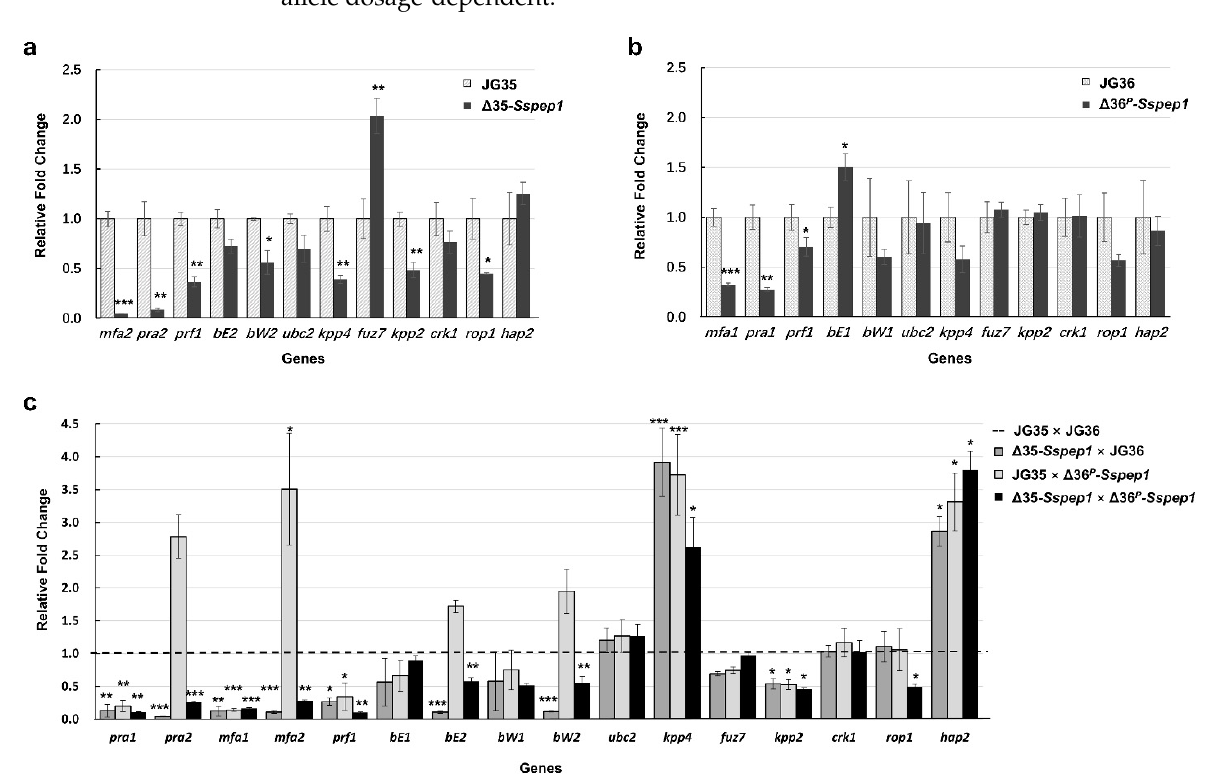
Figure 3. Effects of Sspep1 deletion on the expression of genes essential for mating and filamentous growth in haploid and dikaryon stages. RT-qPCR was used to quantify the accumulation of target genes. ( a ) ∆ 35- Sspep1 ; (b) ∆ 36 P -Sspep1 ; ( c ) mating pairs. The levels of gene expression in the wild-type haploid strains ( a , b ) or pairs of wild-type strains ( c ) were set as 1.0. The actin gene of S. scitamineum was used as an endogenous control. Means ± S.E. were derived from three independent biological repeats, each of which contained three technical repeats. p -values were calculated based on a Student’s t -test of replicate 2 − ∆∆ Ct values for each gene in the wild-type strain and Sspep1 mutant. * p < 0.05, ** p < 0.01, and *** p < 0.001.